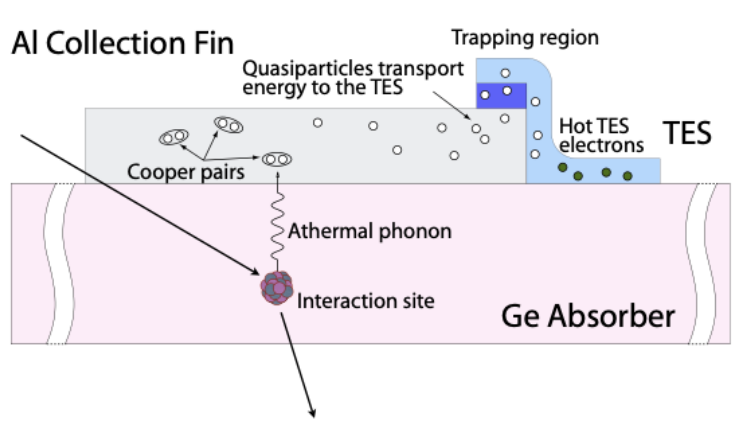
Figure 33: Schematic of a SuperCDMS phonon sensor on the surface of a Ge sub- strate. Phonons produced by particle interactions in the substrate break Cooper pairs in the aluminum fin producing quasiparticles. The quasiparticles diffuse into the TES increasing its temperature. Image provided by the SuperCDMS